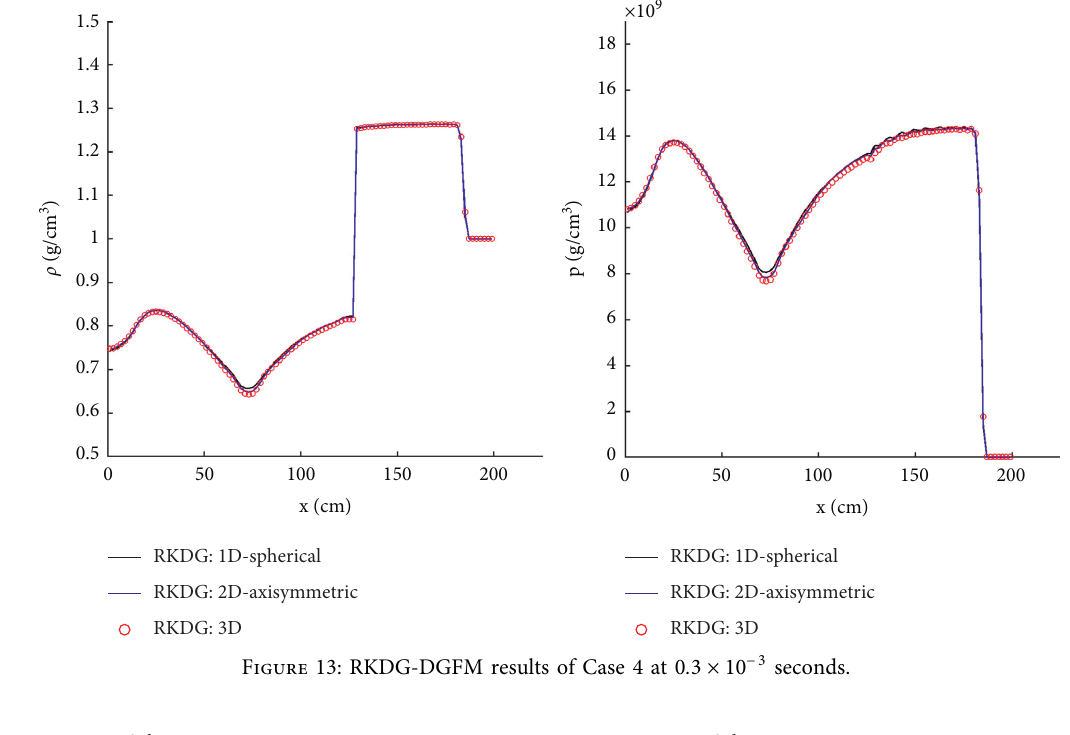
Figure 13: RKDG-DGFM results of Case 4 at 0 . 3 × 10 − 3 seconds.